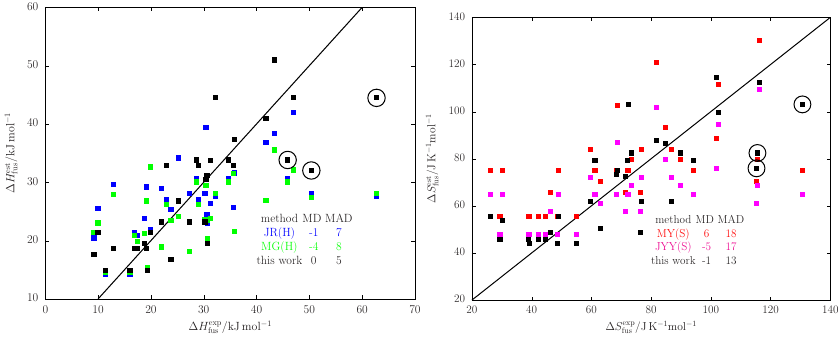
Fig. 5. Estimated vs. experimental ∆ H fus (left) and ∆ S fus (right) for various literature methods, and for the method developed in this work. The MD and MAD of the methods are also given. The 1:1 diagonal is indicated (black line). The three most important outliers of the new method are indicated by a circle (from small to high experimental ∆ H fus : 3-oxoglutaric acid, oxosuccinic acid, tartaric acid).